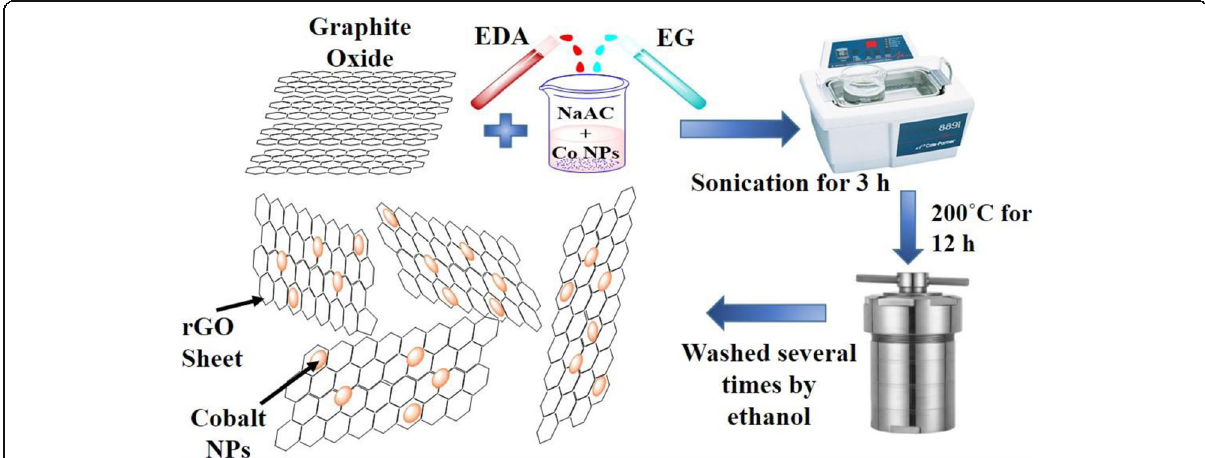
Fig. 1 Schematic diagram illustrating synthesis mechanism of Co-rGO nanohybrid